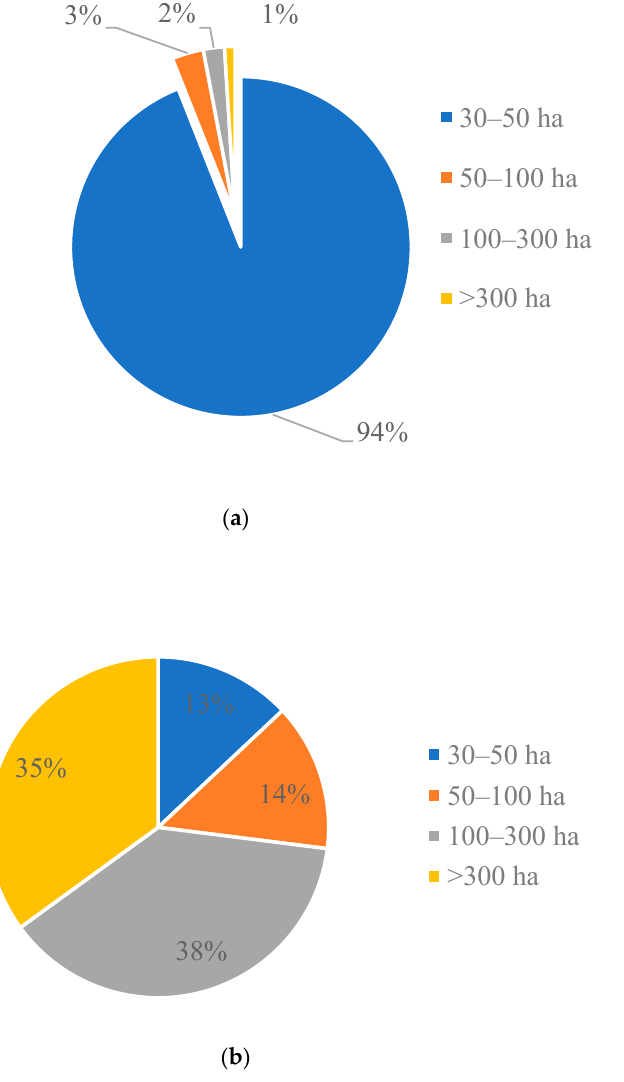
Figure 7. ( a ) Structure of farms in Lithuania in 2018 [28]. ( b ) Structure of farms that insured their crops in 2020.